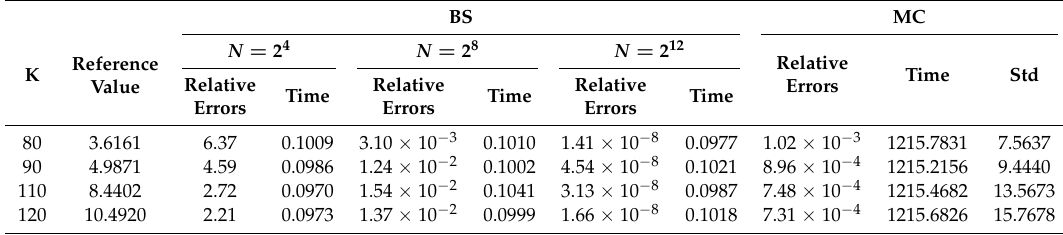
Table 2. Approximation results for guaranteed minimum death benefit (GMDB), where X is BS, b ( s ) = ( K − s ) + .